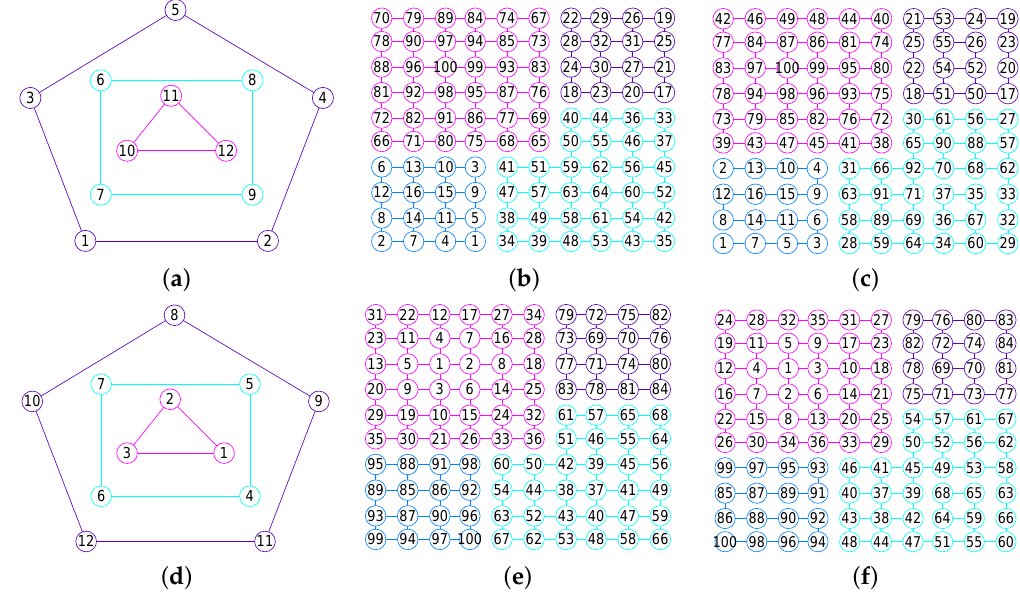
Figure 13. The TopMost graphs of three unconnected graphs G 11 , G 12 and G 13 . ( a ) A disconnected graph G 11 with 12 nodes and 12 edges; ( b ) A disconnected graph G 12 that has four connected components and a total of 100 vertices and 160 edges; ( c ) A disconnected graph G 13 that has four connected components and a total of 100 vertices and 131 edges; ( d ) The TopMost graph of G 11 ; ( e ) The TopMost graph of G 12 ; ( f ) The TopMost graph of G 13 .